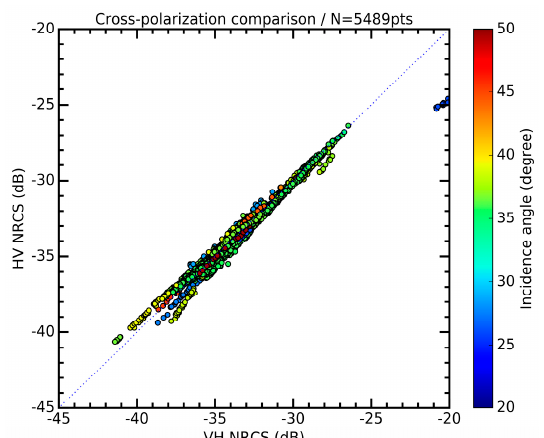
Figure 14. The GF-3 NRCS scatter between VH and HV polarization. The color bar represents the incidence angle.